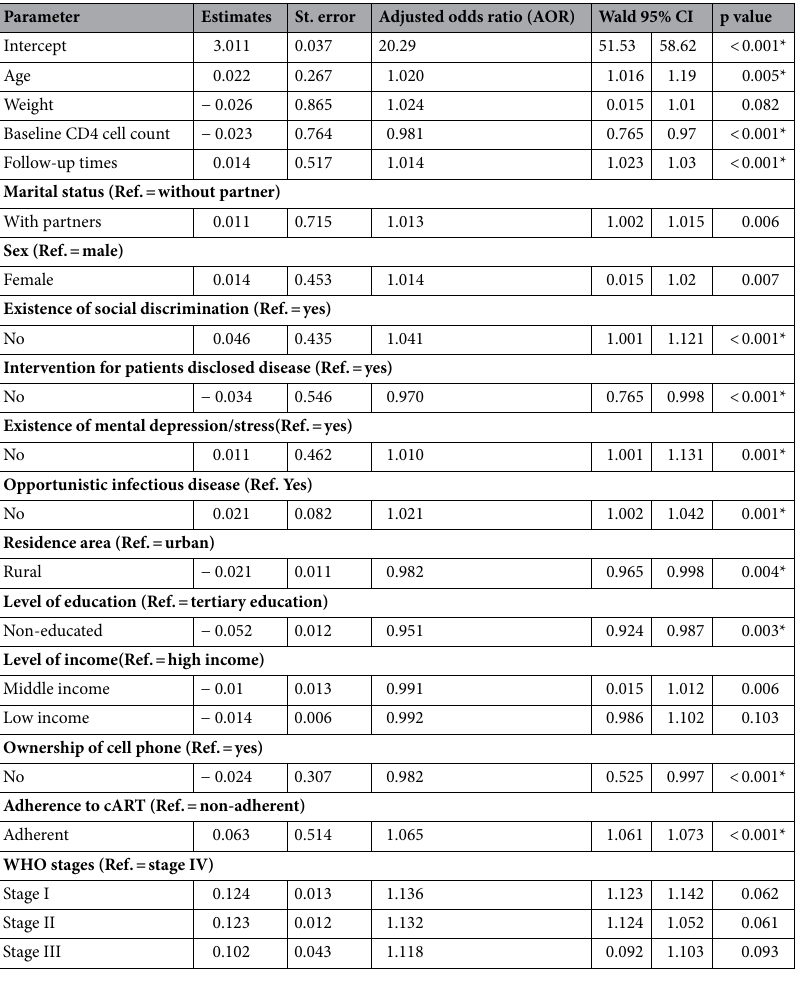
Table 4. Parameter estimates for disclosure of HIV status data using a linear predictor. *Significant at 95% CI for both outcomes, e β =